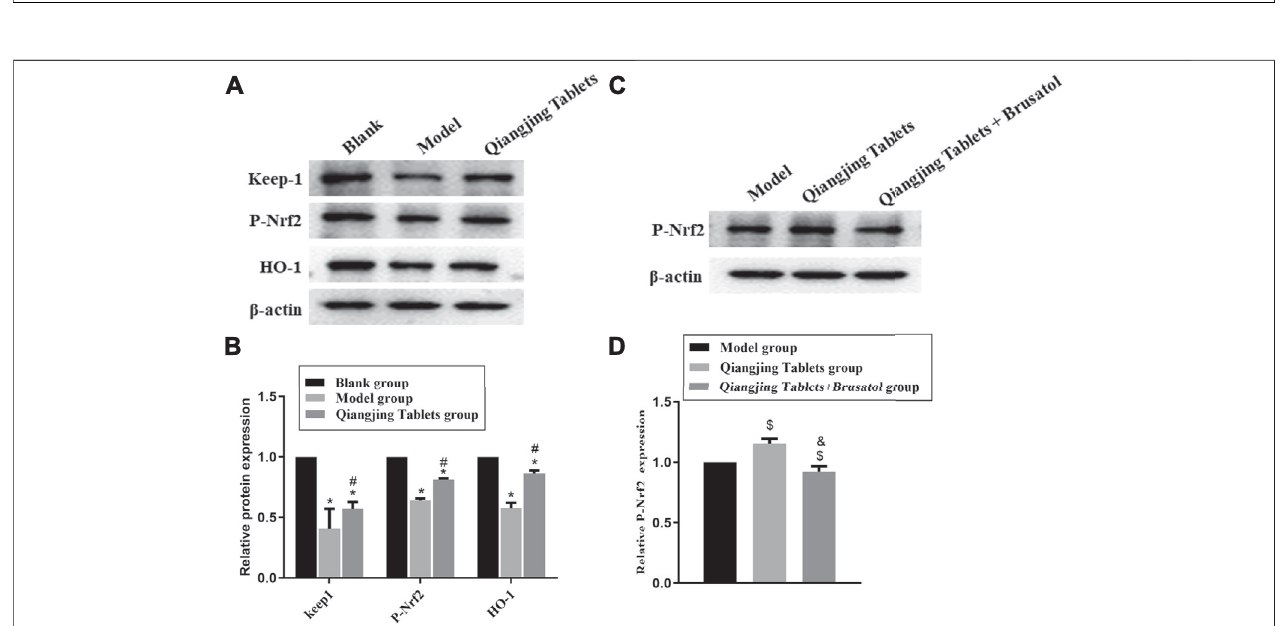
FIGURE 7 | Effect of Qiangjing Tablets on Nrf2/ARE pathway in AZS rats. (A) Western blotting was used to assay the expression of P-Nrf2, Keap1 and HO-1 in Blank,ModelandQiangjingTabletsgroups. (B) OpticaldensityvaluesofP-Nrf2,Keap1andHO-1werequanti fi edandanalyzedineachgroup. (C) Westernblottingwas applied to detect the expression of P-Nrf2 in Model, Qiangjing Tablets and Qiangjing Tablets + Brusatol groups. (D) Optical density values of P-Nrf2 was quanti fi ed and analyzed in each group. Values are expressed as mean ± SD, n (cid:2) 15 per group. * p < 0.05 vs. Blank group; # p < 0.05 vs. model group; $ p < 0.05 vs. model group; & p < 0.05 vs. Qiangjing Tablets